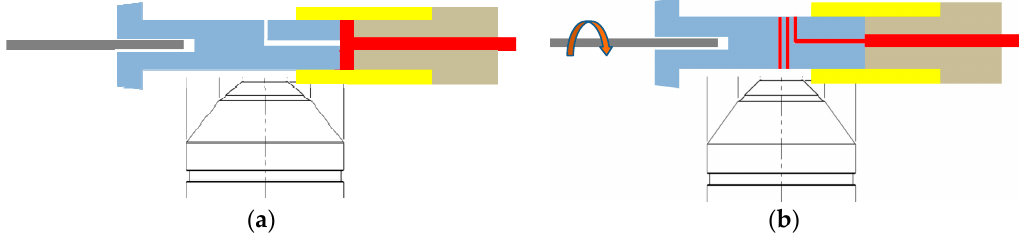
Figure 7. Schematic of the integrated nut-and-bolt microfluidic system for sample loading, reaction, transport, and detection. ( a ) Blood sample loaded in the mixing chamber of the sample cartridge from a microcapillary tube filled with capillary blood (blood sample is colored in red). ( b ) Sample introduced to the helical minichannel in the sample cartridge for CD4 detection by rotating the motor after the reaction process.